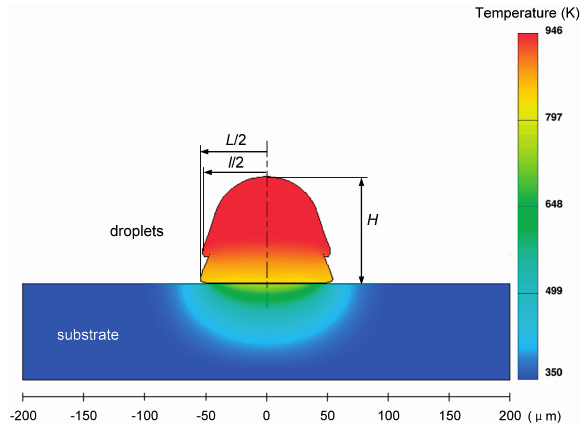
Figure 7. Simulated deformation and temperature distribution of 100- μ m diameter aluminum alloy droplets, initially at 960 K, and their impingement on a stainless substrate at t = 202 μ s; impact velocity is 3 m/s and the distance between the two successive droplets is 280 μ